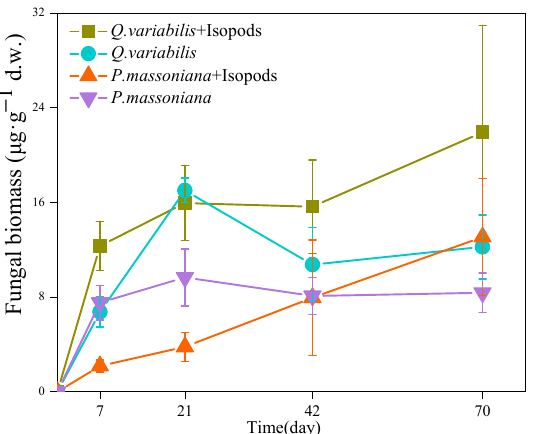
Figure 2. Fungal biomass changes in the decomposition area under different treatment during 70 days incubation.